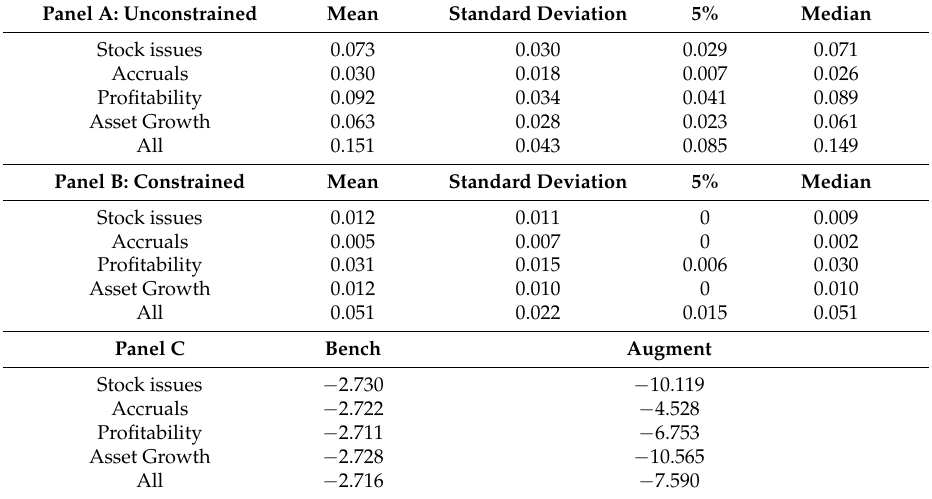
Table 4. Posterior Distribution of the DSharpe Measure of the Additional Model 2